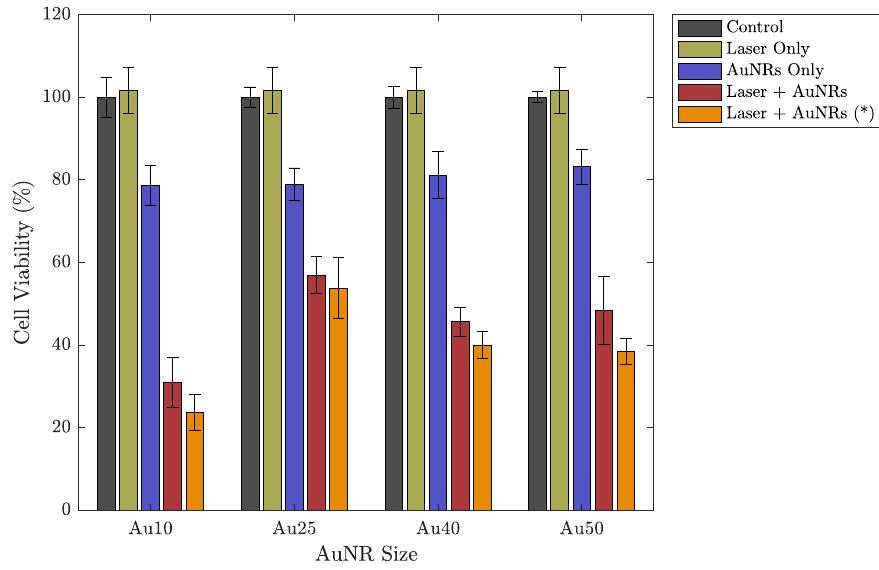
Figure 3. Cell viability of a lung cancer cell line (A549) under different experimental parameters: a control group representing no incubation with AuNRs or laser exposure (grey), after 5min exposure to laser irradiation without AuNRs (light green), after incubation with different sized AuNRs without laser irradiation (purple), after incubation with different sized AuNRs followed by a 5min laser exposure (red), after incubation with different sized AuNRs followed by a 5min laser exposure after replacing the AuNR-media solution with fresh media (orange (*)). Errorbars represent the standard deviation.